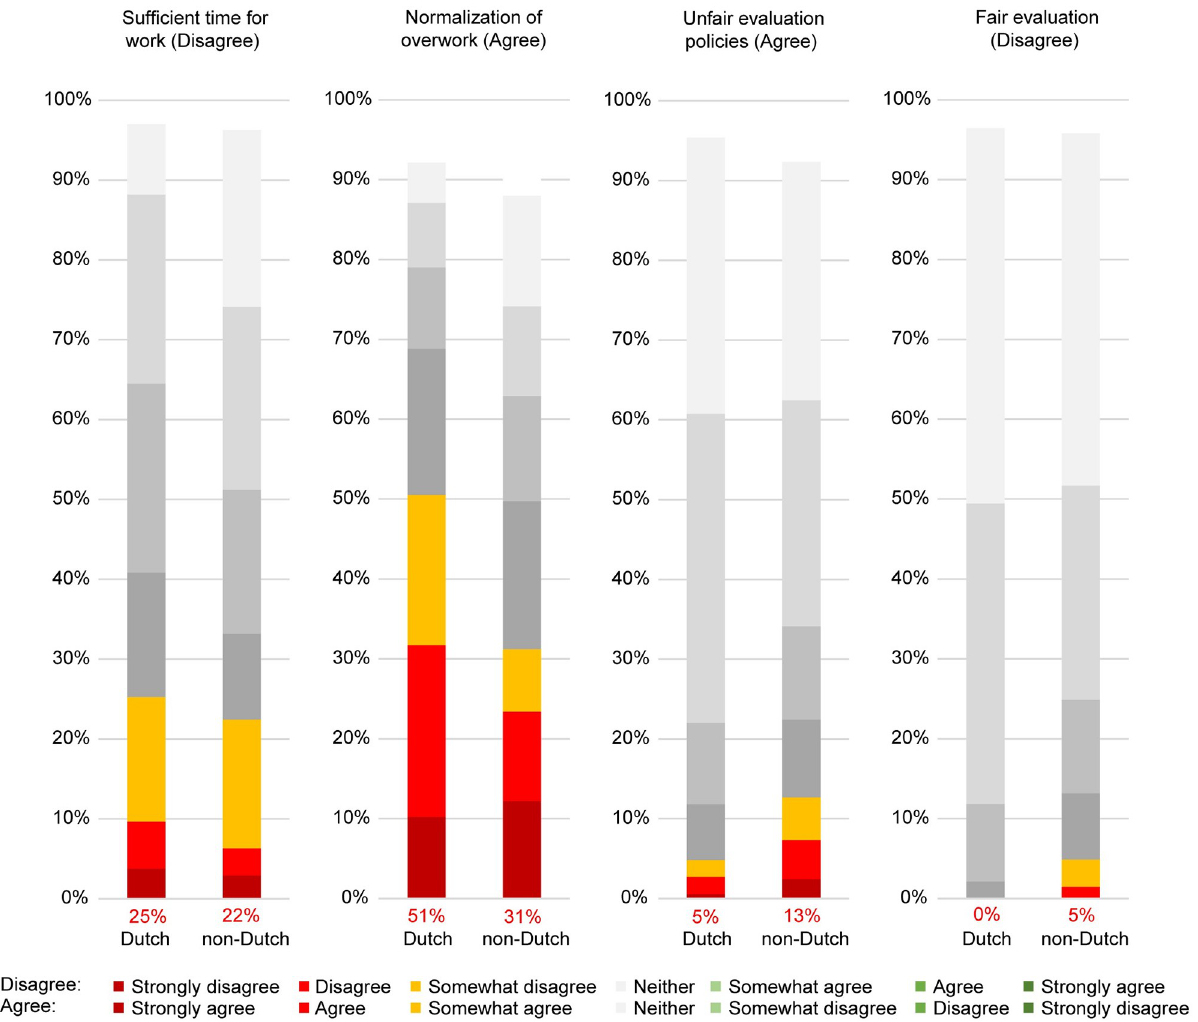
Fig 7. Rate of Dutch and non-Dutch PhD candidates who report experiencing sufficient time for work, unfair evaluation policies, or normalization of overwork. Note : Scales range either from strongly disagree to strongly agree (marked “disagree”) or the opposite, strongly agree to strongly disagree (marked “agree”). Numbers in red represent the rate of respondents who at least “somewhat